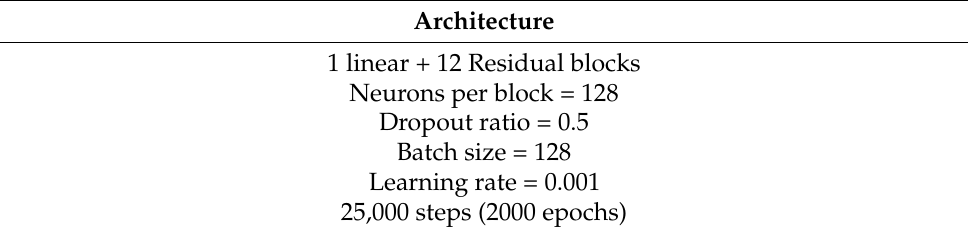
Table 3. Selected model architecture with the highest